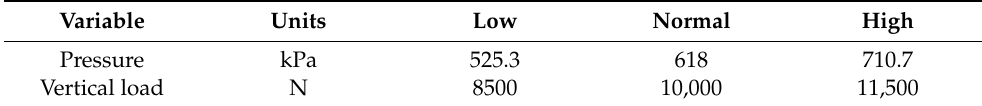
Table 4. Parameter conditions adopted in the simulation.